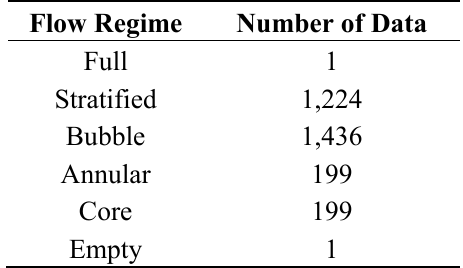
Table 1. Number of flow patterns generated for each θ